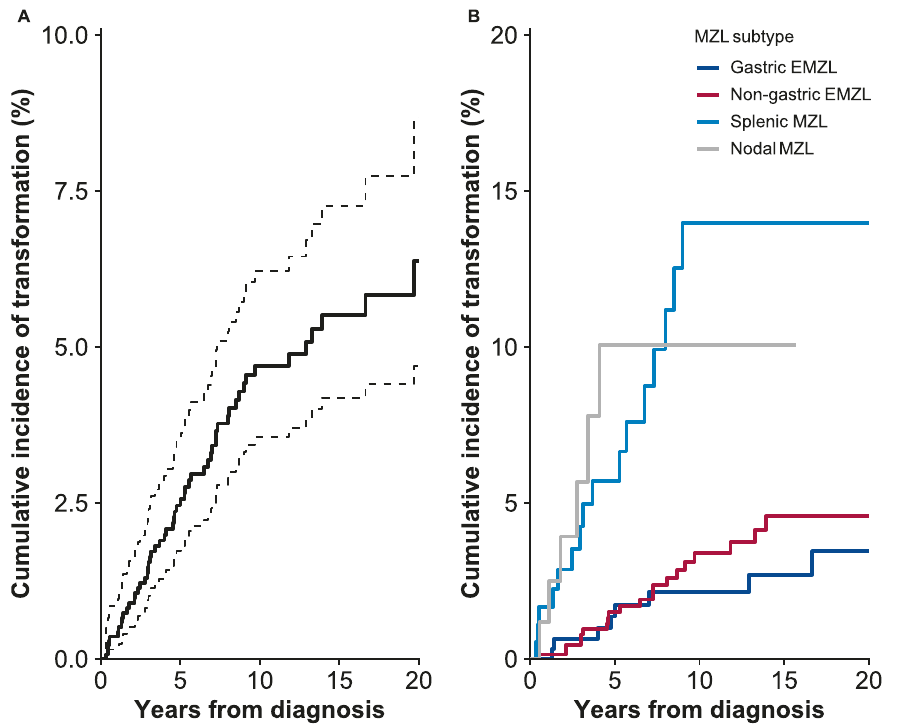
Fig. 1 Cumulative incidence of transformation in patients diagnosed with marginal zone lymphoma in Finland in 1995 – 2018. A Cumulative incidence of transformation for the whole cohort with 95% con fi dence intervals; B Cumulative incidence of transformation strati fi ed by marginal zone lymphoma subtype. Estimates for unclassi fi able subtypes are not shown. MZL marginal zone lymphoma, EMZL extranodal marginal zone lymphoma. Table 2. Hazard ratios for incident transformation in patients with marginal zone